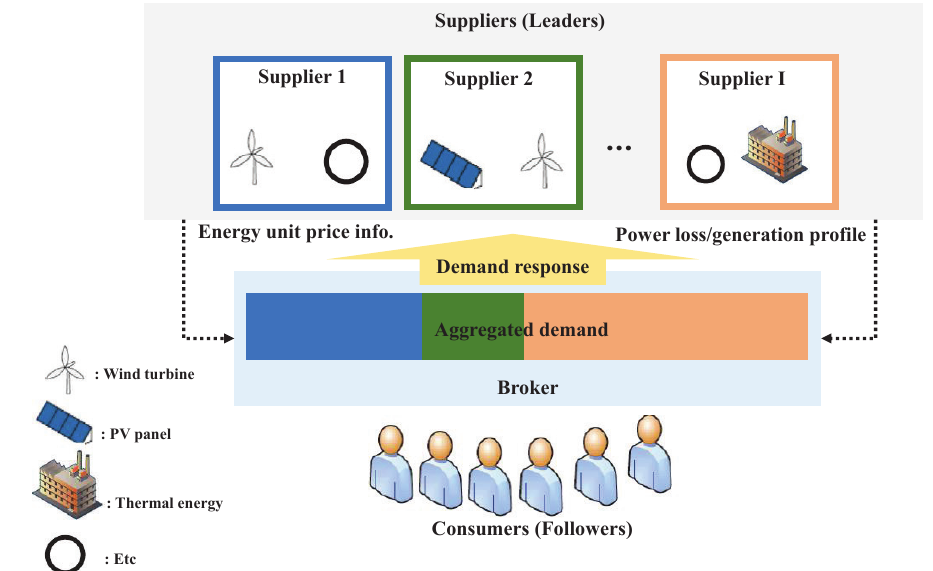
Figure 1. Stackelberg game model. PV: